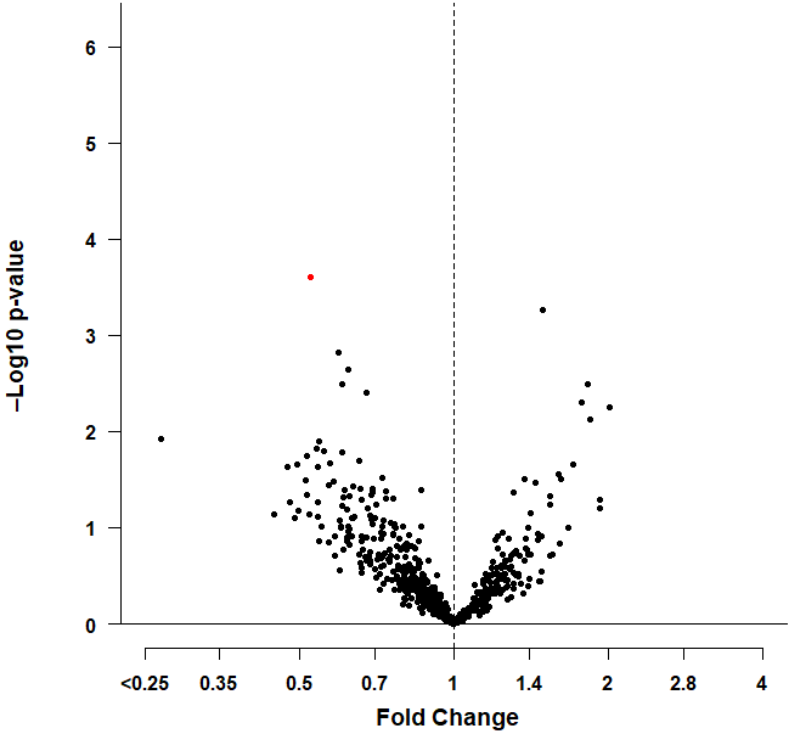
Figure 2. Volcano plot of nominally significant miRNAs in association with prevalent atrial fibrillation among men. The y-axis of Figure 2 represents the negative log of the p-value on the y-axis and the x-axis represents the log of the fold change for prevalent AF. The black dots indicate the associations of the nominally significant miRNAs. The red dot indicates the significant association after correction for multiple testing of miR-4798-3p.